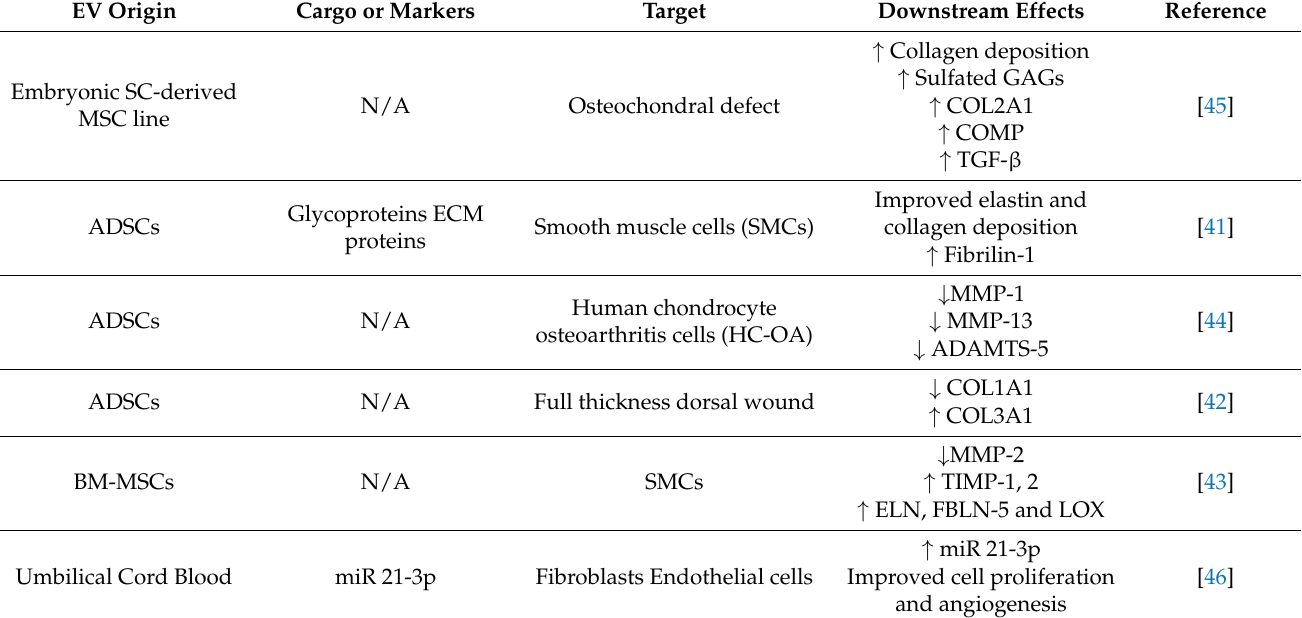
Table 1. Origin, cargo/markers, target, and downstream reparative effects of